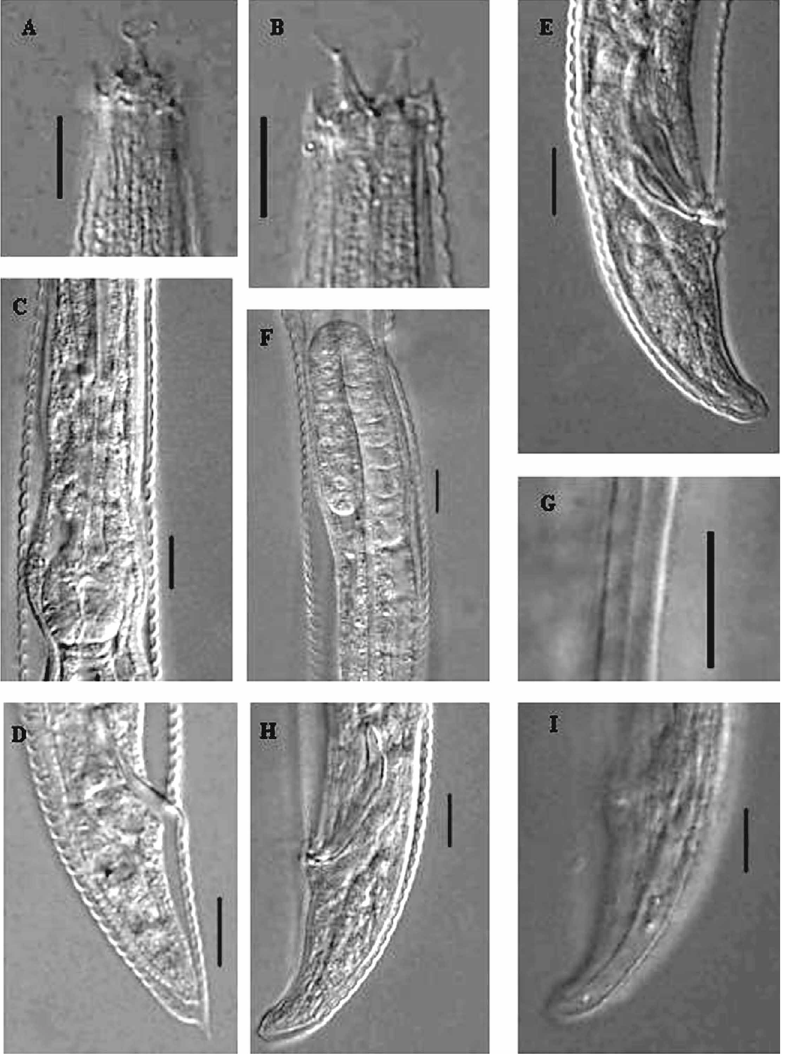
Figure 1. Cervidellus vexilliger A & B - Anterior regions; C - Pharynx; D - Female tail; E - Male posterior region; F - Male gonad; G - Lateral lines; H - Male spicule; I - Male genital papillae. (Scale =